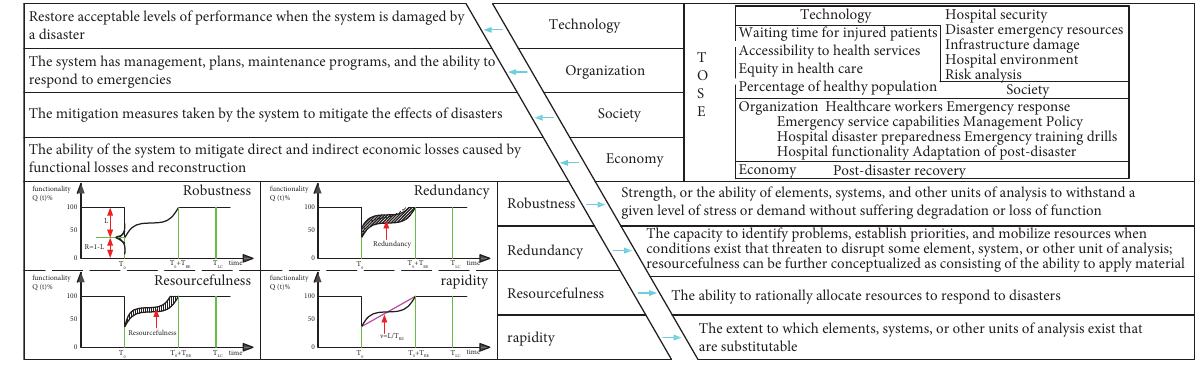
Figure 1: Resilience analysis of four dimensions (TOSE) and four characteristics